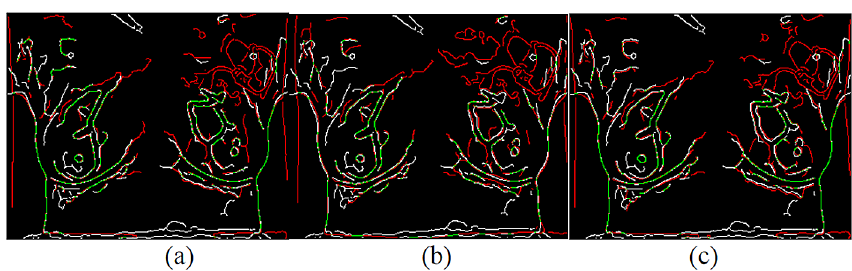
Figure 10. Canny overlays of TYPE II images obtained with ( a ) the proposed ( b ) Lee et al . ( c ) Optical